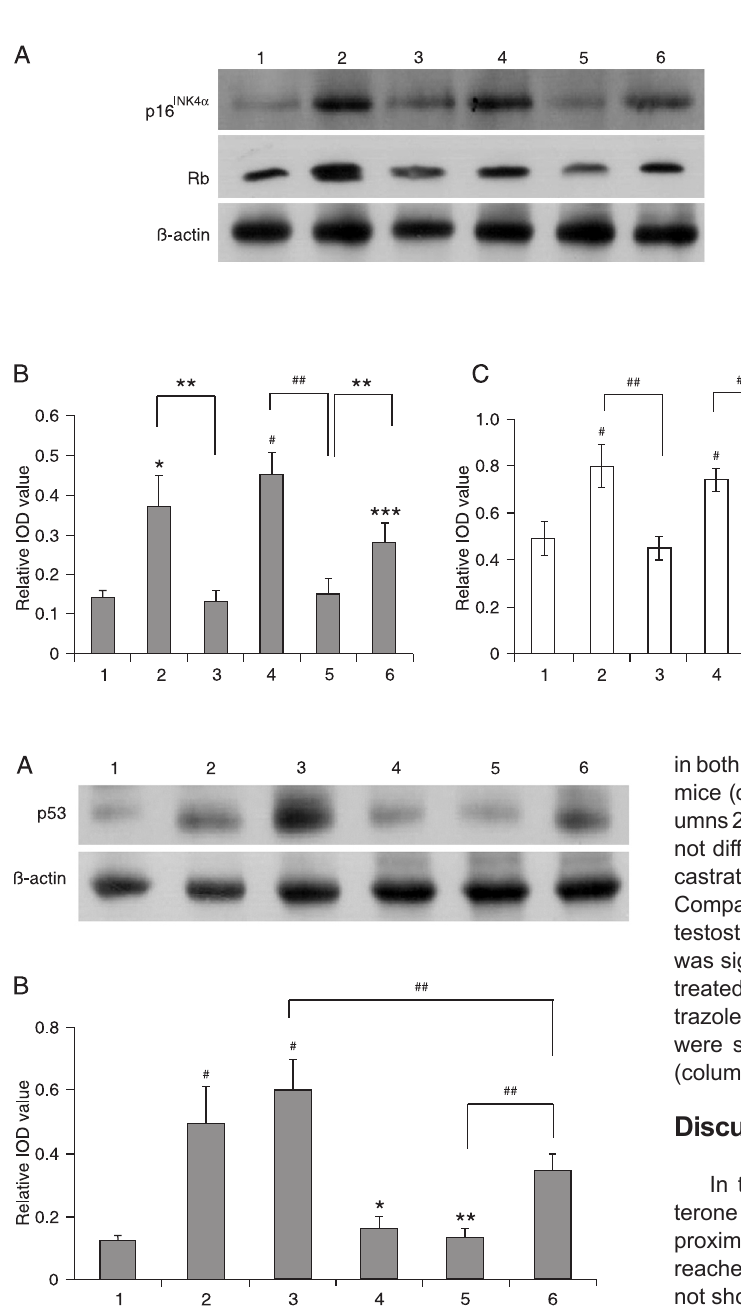
Figure 4. Western blot analysis of p53 protein with β-actin as an in - ternal control ( A ). Densitometric analysis of p53 protein ( B) . Columns : 1 , control group; 2 , castrated group; 3 , sham-operated Tfm group; 4 , castrated + testosterone group; 5 , sham-operated Tfm + testosterone group; 6 , sham-operated Tfm + testosterone + anastrazole group. Data are reported as means ± SD. # P < 0.01 compared to control group; *P < 0.01 compared to castrated group; **P < 0.01 compared to sham-op- erated Tfm group; ## P < 0.01 (ANOVA + LSD test). There were no sig- nificant differences between castrated and sham-operated Tfm mice or between testosterone-treated castrated and sham-operated Tfm mice. Tfm = testicular feminized mouse; IOD = integrated optical